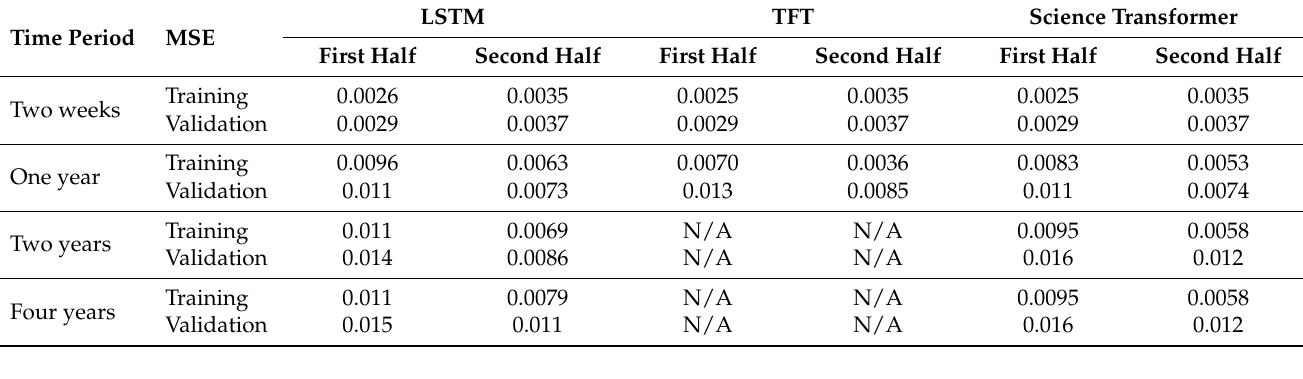
Table 7. Mean square error over first and second 35-year periods of data averaged over location and two-week time interval.